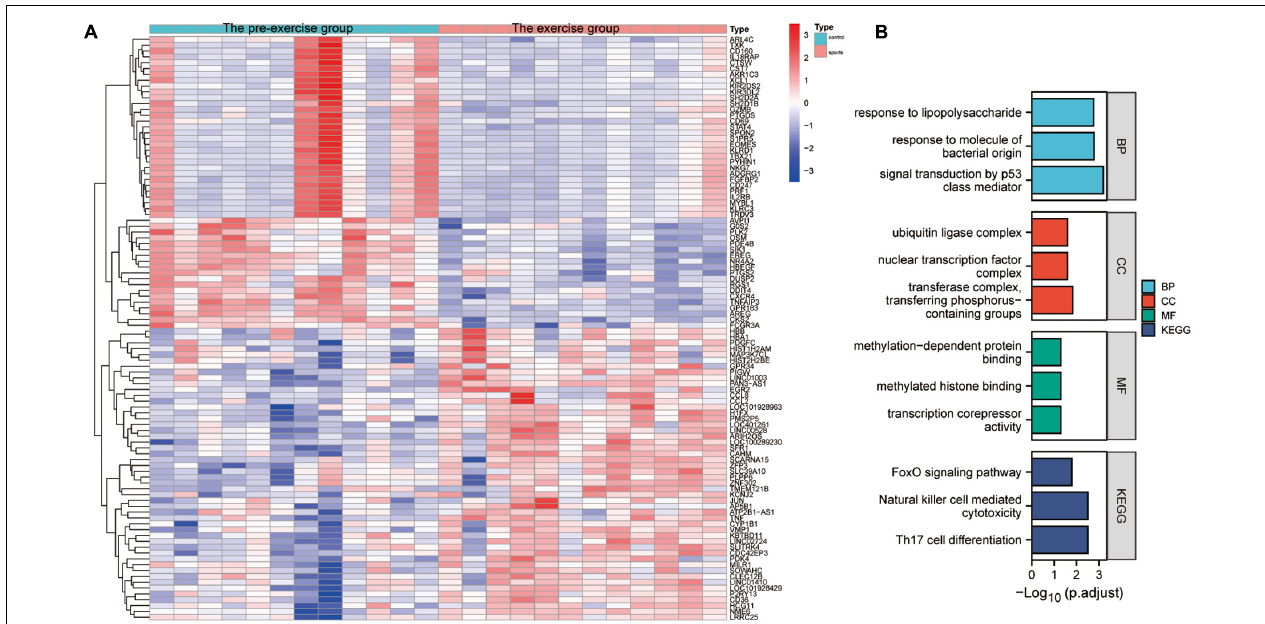
FIGURE 3 | Characterization of the effect of the exercise group on the expression profile of monocytes. (A) Heat map of the major DEGs in monocytes from the GSE51835 bulk RNA dataset before versus after the patients received exercise; (B) GO and KEGG enrichment analysis of the major DEGs in